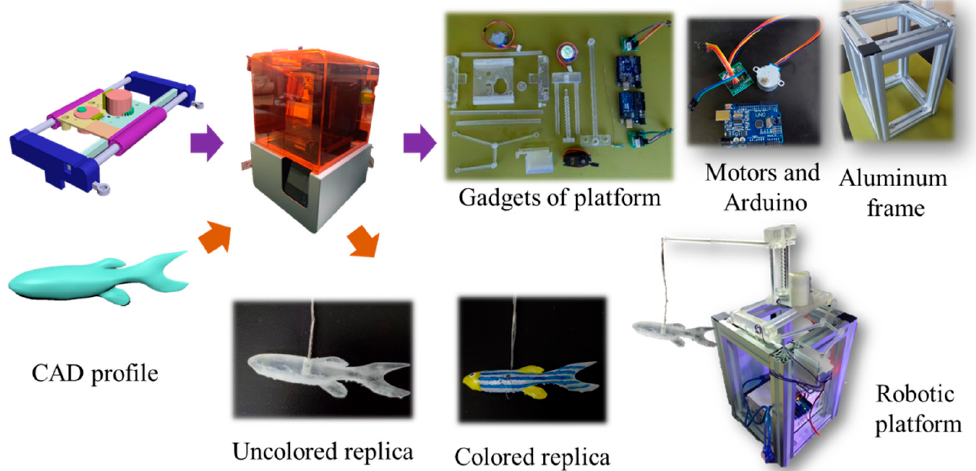
Figure 1. Manufacturing flow for the robotic and sensing platform.